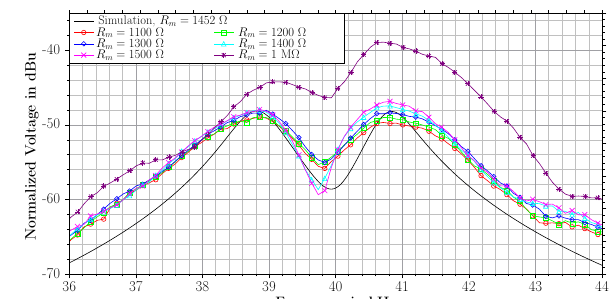
Figure 10. Measured magnitude for matched and unmatched piezo- electric devices (MA40S4R) for different measurement resistors. The impedance of the series resonance remains nearly constant for different resistor values. Indeed, the impedance of the parallel reso- nance decreases for lower resistor values.